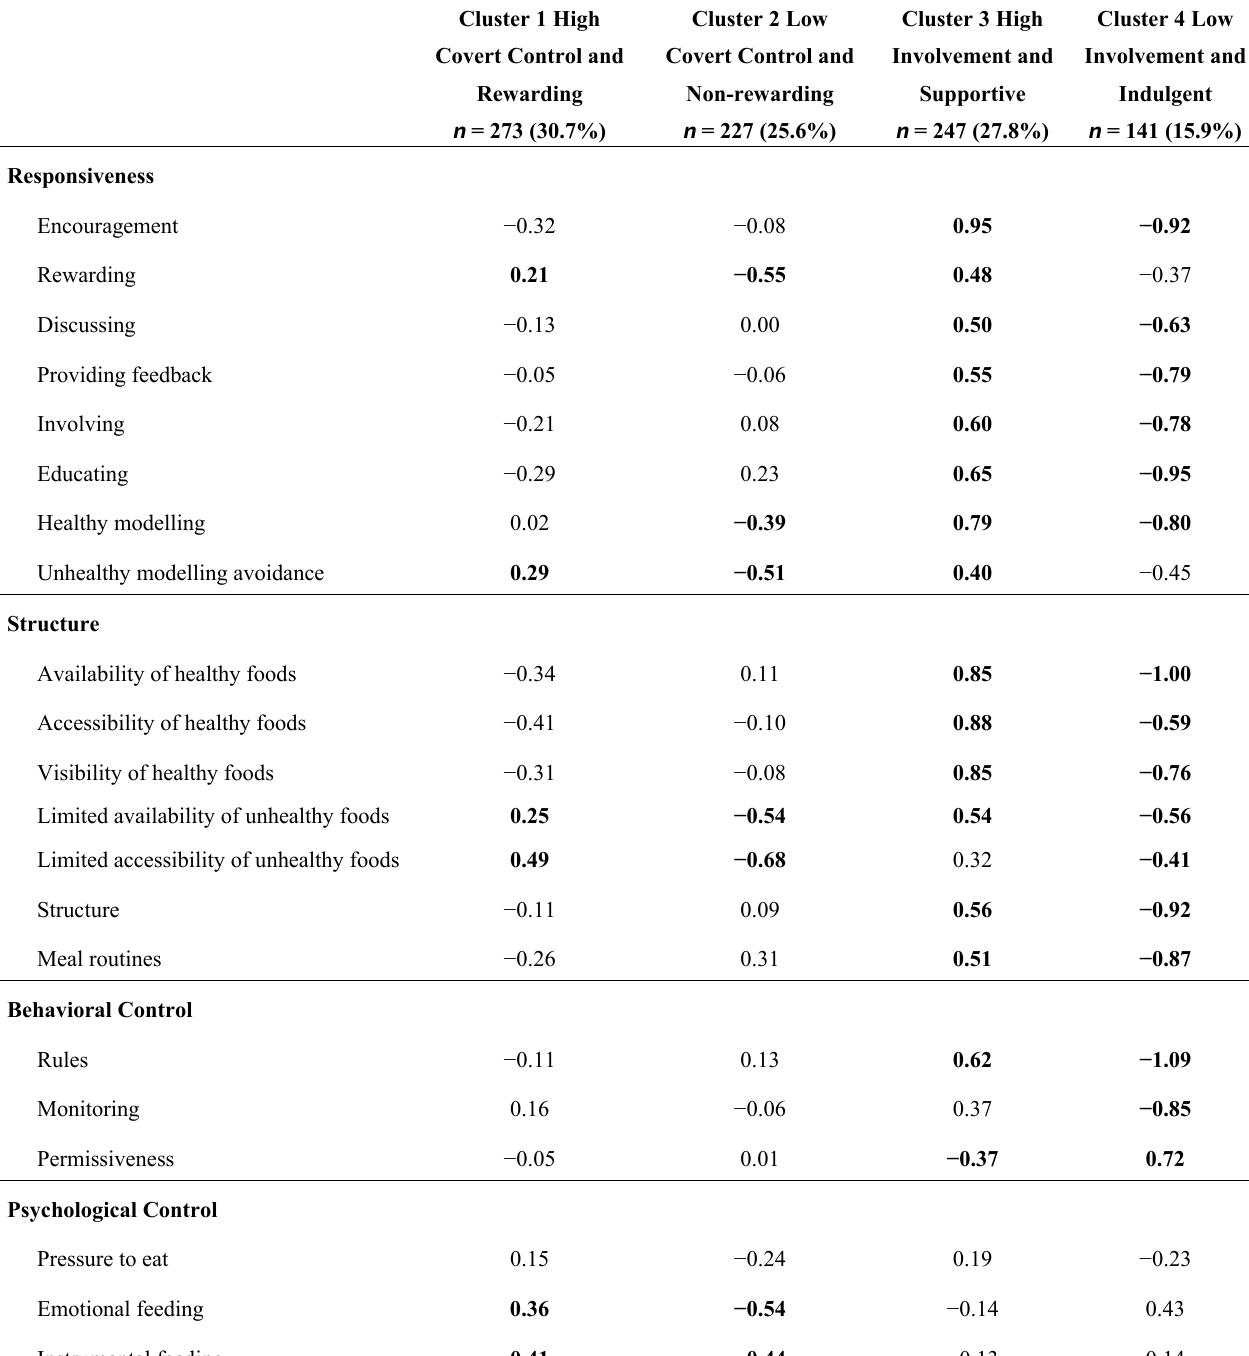
Table 1. Four-cluster solution: Mean z-scores for all food parenting practices ( n = 888). Cluster 1